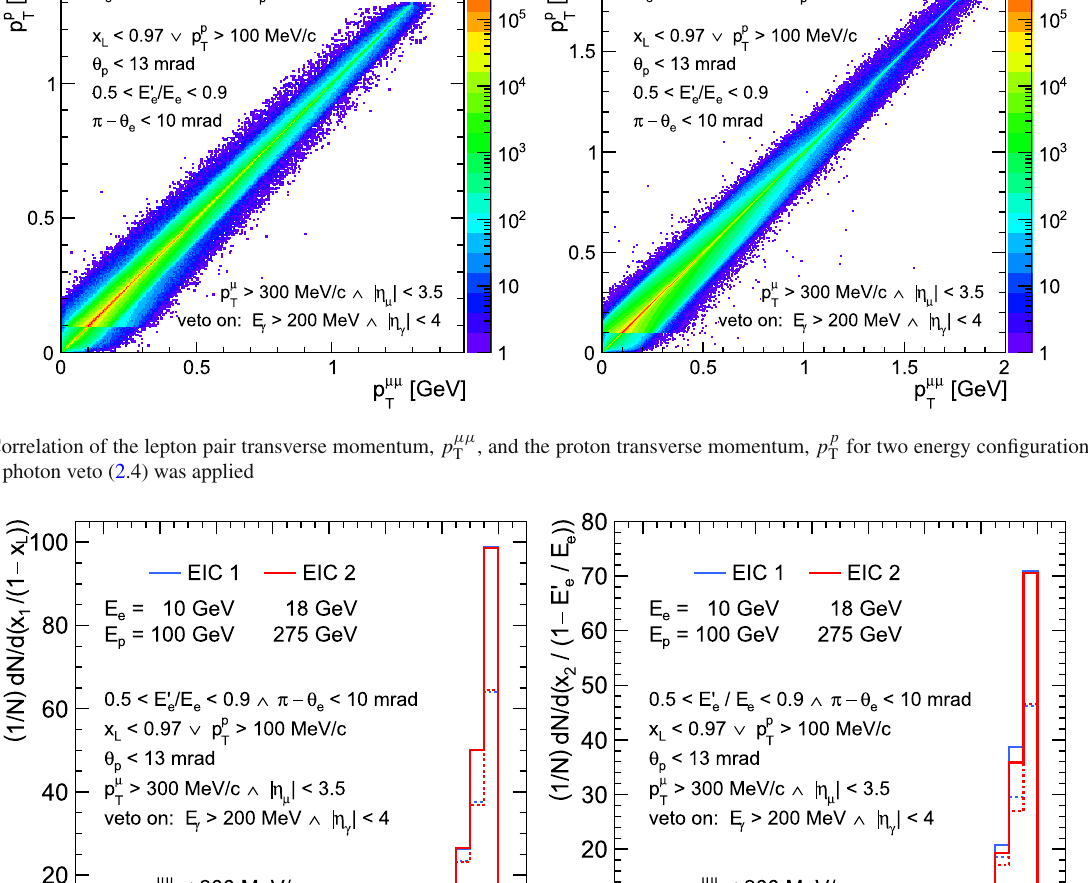
Fig. 3 Distributions of x 1 /( 1 − x L ) and x 2 /( 1 − E (cid:2) e / E e ) with (solid line) and without (dotted line) the cut on the transverse momentum of the μμ < 200 MeV/ lepton pair p T